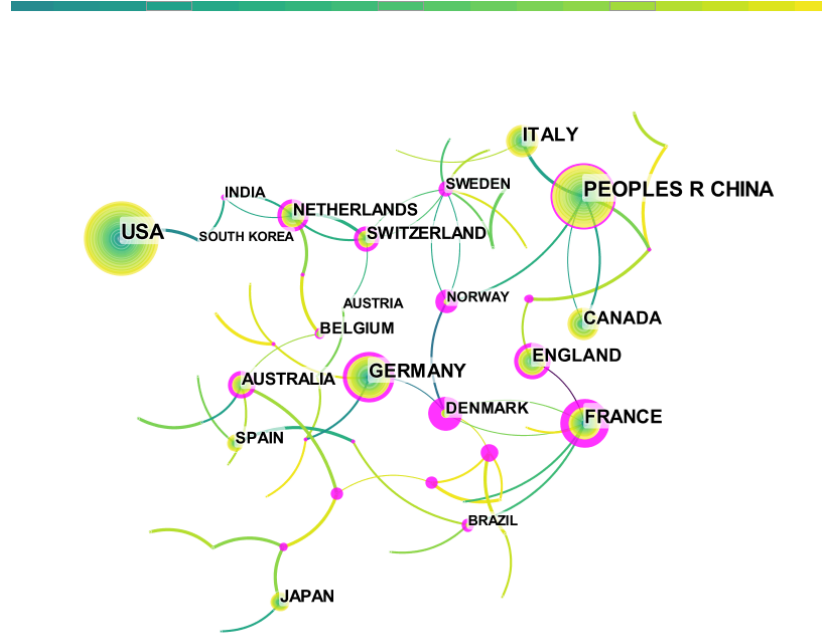
Figure 2. Country/territory cooperation network map. The colored line at the top in Figure 2 represents the years from old to new from left to right. A node represents a country/region. The size of the node is directly proportional to the number of articles published, each node is described as a series of tree rings with different colors (corresponding to different years), and the surrounding purple rings indicate good concentration. The link represents the common reference or common occurrence between these nodes; the color of the link represents the year when the two nodes co-occur; the thickness of the line indicates the closeness of the partnership.